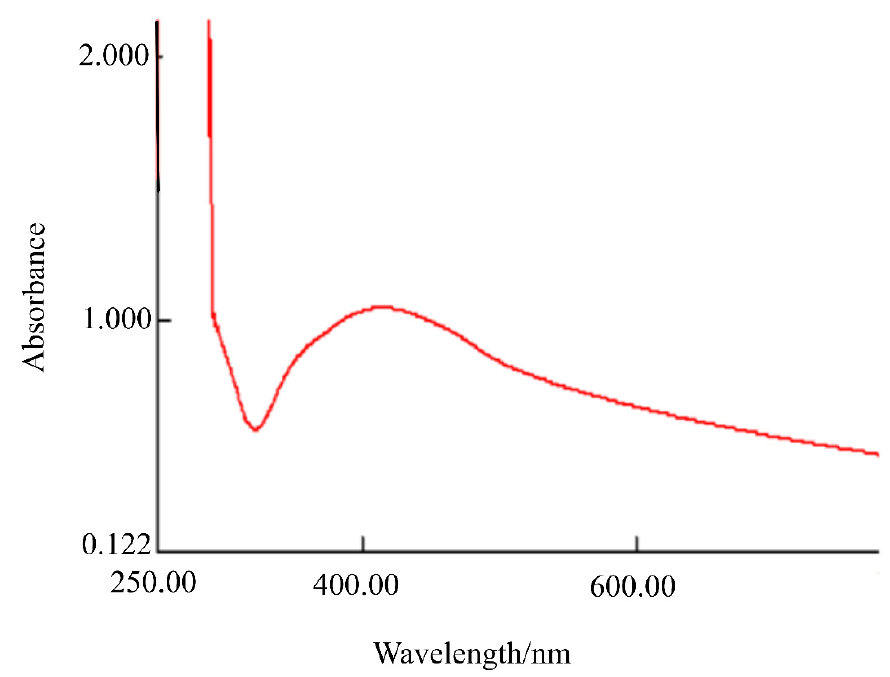
Figure 4. UV-vis spectrum of AgNPs@Sa.